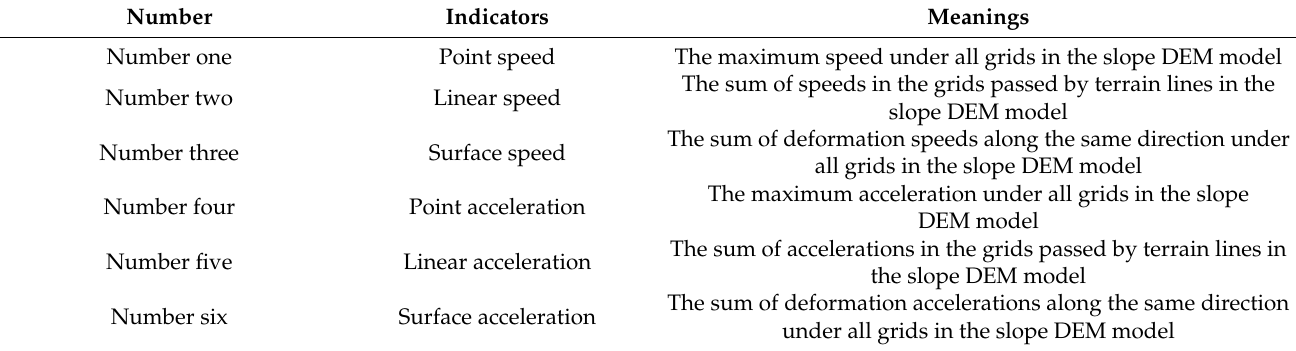
Table 1. The meanings of all indicators.